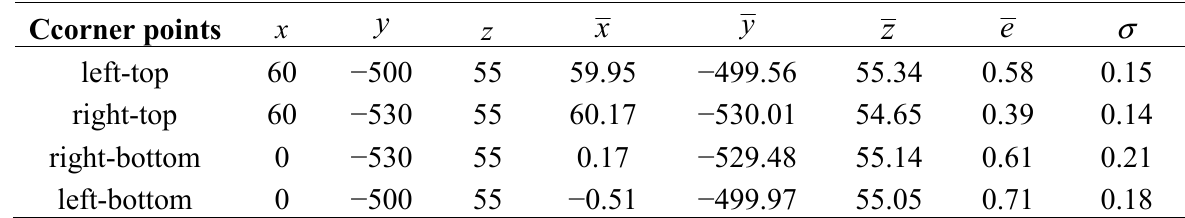
Table 3. Measurement results for verification